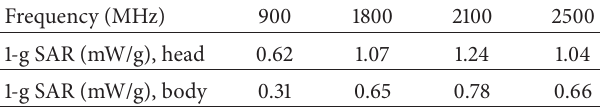
Table 3: Measured 1-g SAR